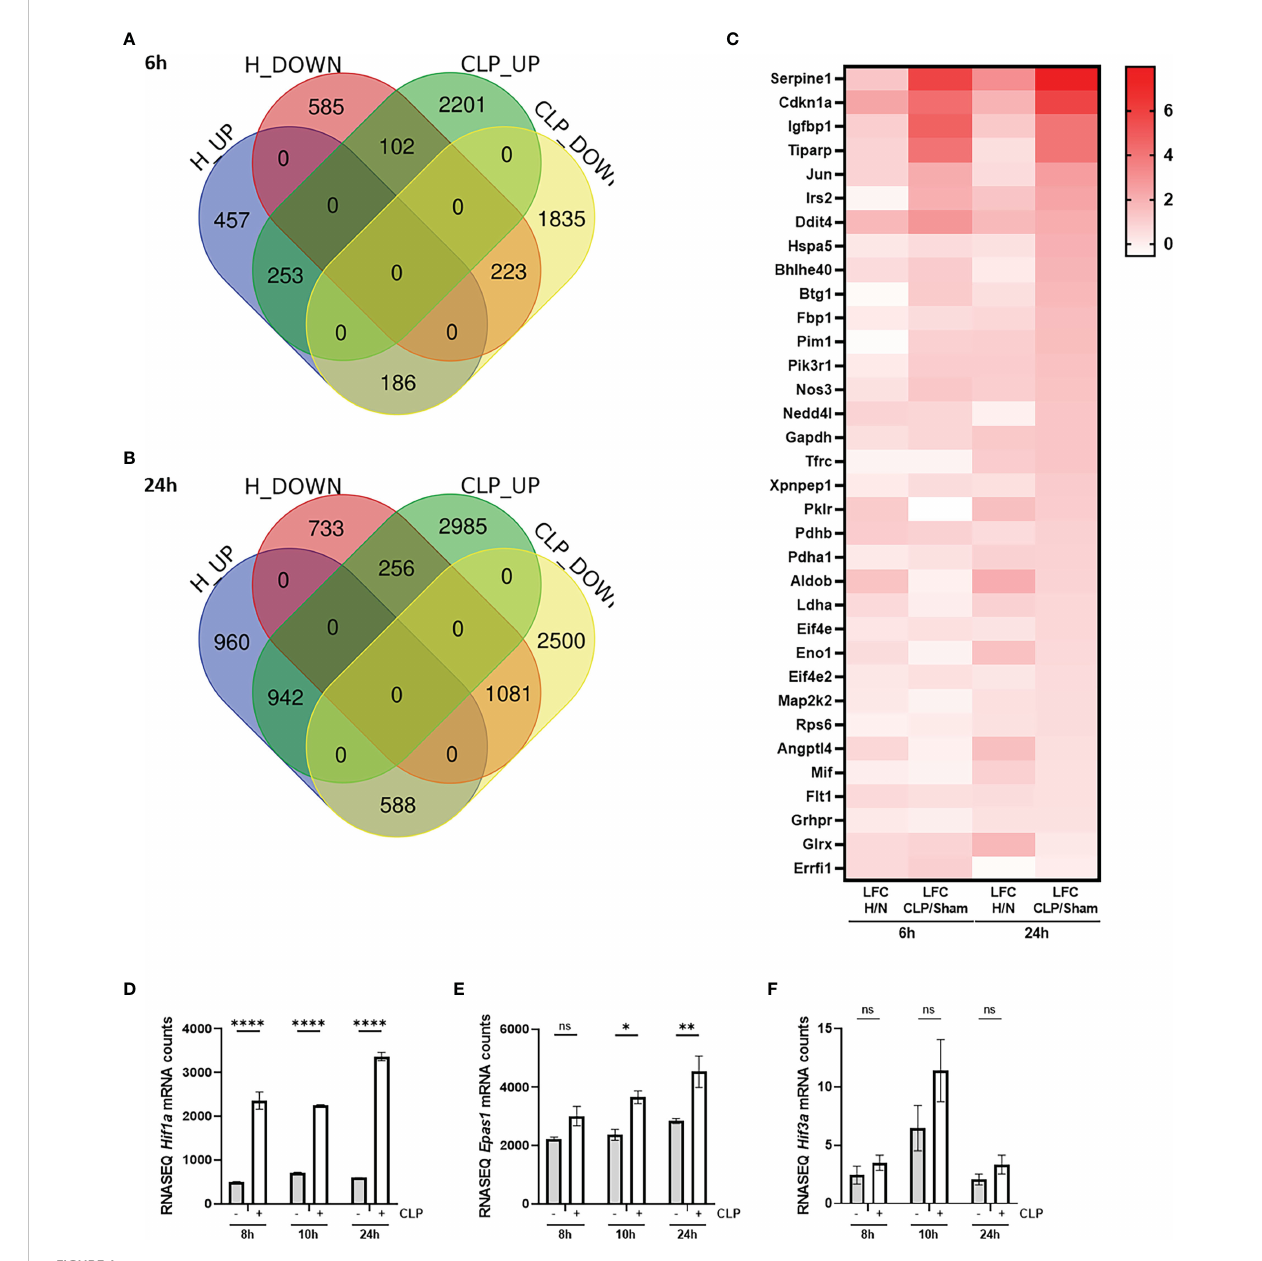
FIGURE 1 HIF signaling is enriched during sepsis. (A, B) C57BL/6J mice were put in normoxia or hypoxia and sham or CLP, and livers were isolated after 6h (A) and 24h (B) for genome-wide transcriptomics via RNA-SEQ. Venn diagram depicting the overlap between genes that are upregulated (up, P < 0.05 & LFC > 0) and downregulated (down, P < 0.05 & LFC < 0) by hypoxia and CLP at the indicated timepoints. (C) Heatmap based on the genes identi fi ed via Enrichr pathway analysis (MSigDB Hallmark 2020) signi fi cantly upregulated by CLP and by hypoxia. Log fold changes (LFCs) are depicted. (D-F) C57BL/6J mice were subjected to a sham or CLP procedure and the liver was isolated at the indicated timepoints. RNA-SEQ mRNA counts are shown for Hif1a (D) , Epas1 (E) and Hif3a (F) . All bars represent mean ± SEM. P-values were calculated using two-way ANOVA. ****P < 0.0001, ** P ≤ 0.01; * P ≤ 0.05. ns, non-signi fi